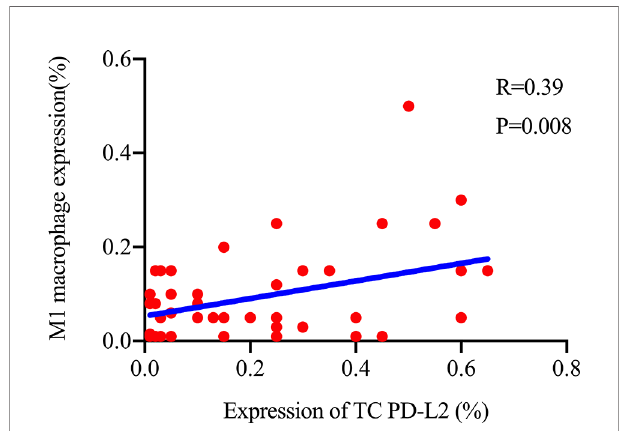
FIGURE 7 | Relationship between the expression of TC PD-L2 and M1 macrophages in